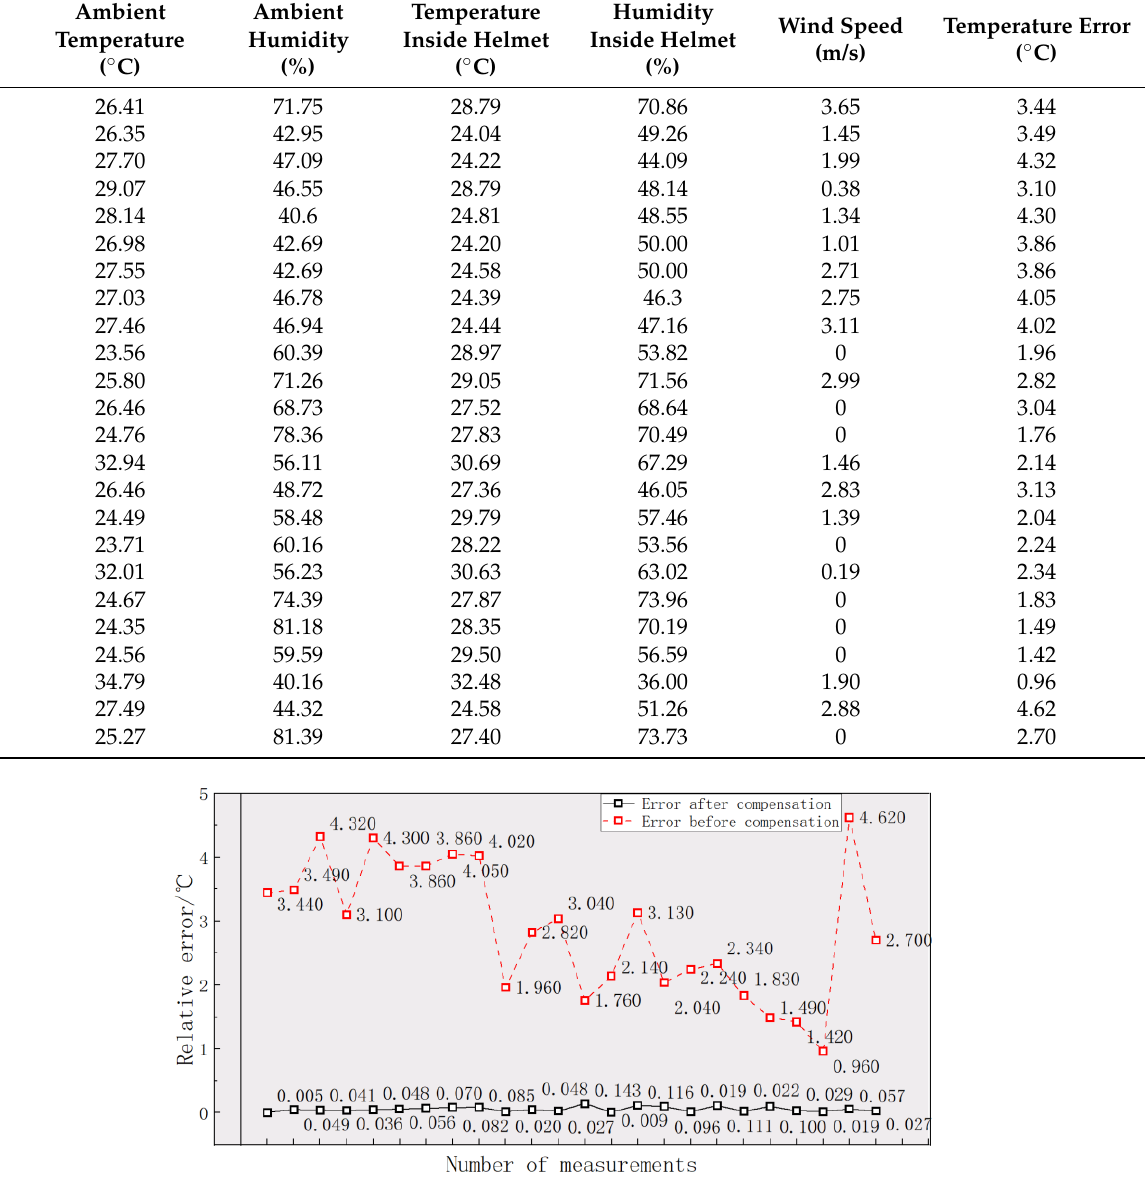
Figure 11. Temperature error before and after compensation of PLS-BPNN model.